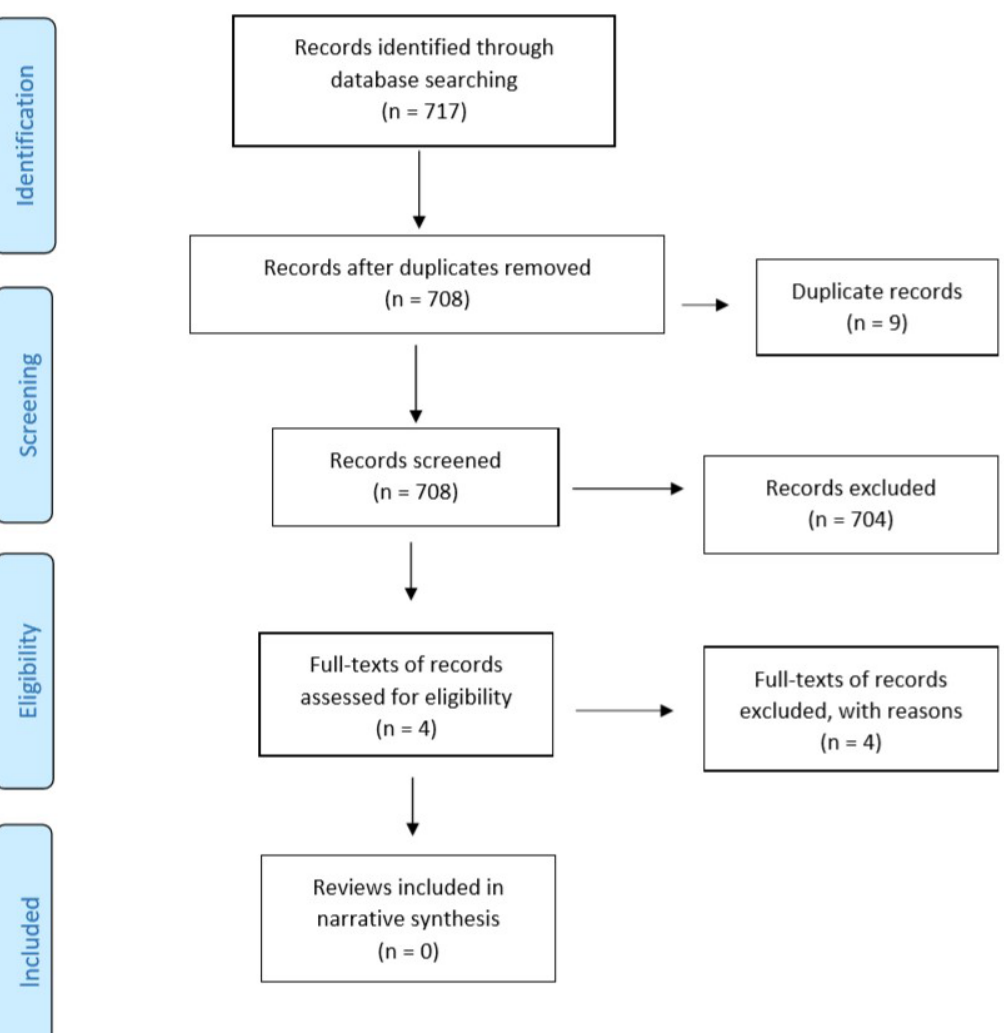
Figure 2. PRISMA study flow diagram (updated search). Updated search from April 2019 to April